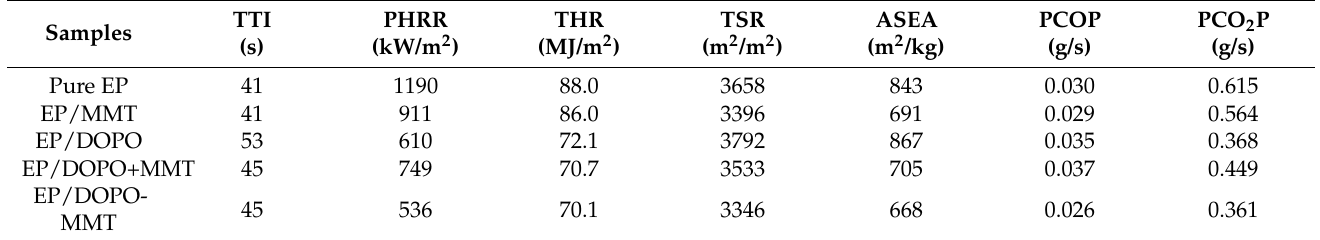
Table 4. CONE data of epoxy resin composites.